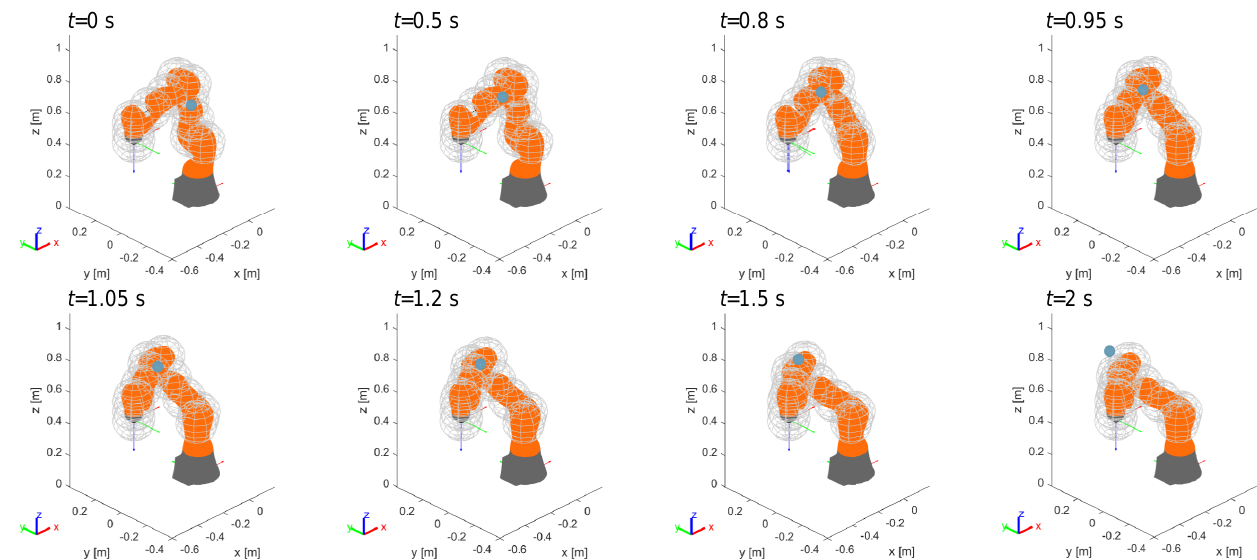
Figure 12. Example 2: avoidance of a dynamic obstacle interfering with an internal point of the manipulator.